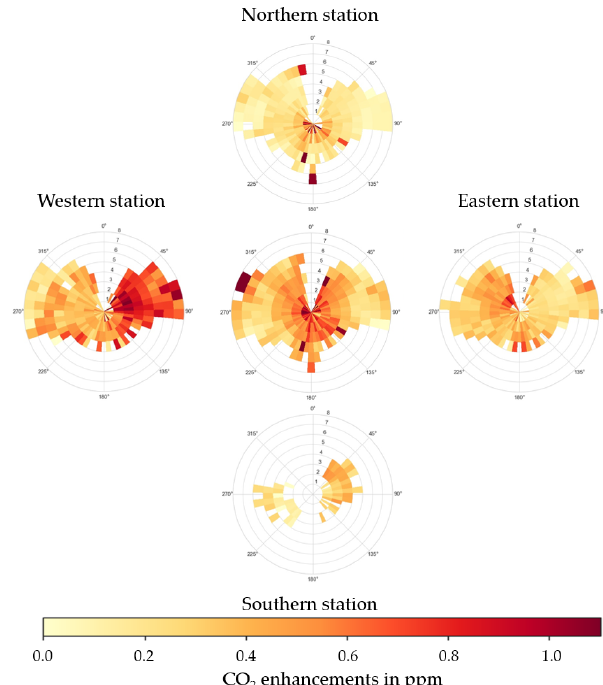
Figure 12. Concentration enhancements over the background for each of the five stations displayed as a polar histogram. The CO 2 enhancements are represented by the different colors (low (yellow) to red (high)). The wind direction is indicated by the location of the respective cells in the circle, and the wind speed by the distance of the cells to the center point. Table 1. Start of operation including the number of measurements taken by each station so far (until 12 August 2020).